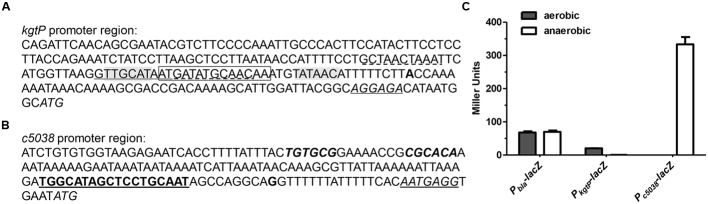
c5038 transcription was induced whereas kgtP repressed in anaerobiosis. (A) Promoter region of kgtP. (B) Promoter region of c5038. Italic, start codon; italic and underlined, putative ribosome binding site; bold, transcription start site; bold and underlined, RpoN binding site/σ54 motif (–12 and –24 regions); italic and bold, inverted repeats for KguR binding; shaded, –10 and –35 regions; Underlined (solid), perfect ArcA binding site; underlined (dashed), imperfect ArcA binding site; boxed, FNR binding site. (C)
kgtP and c5038 expression under aerobic and anaerobic conditions. Bacteria were grown aerobically or anaerobically in M9 medium containing KG as the sole carbon source. TMAO was used as an electron acceptor for anaerobic tests. Expression of c5038-lacZ or kgtP-lacZ was indicated by β-galactosidase activity. Pbla-lacZ constitutive expression was used as a control. Bars represent means ± SEM from three independent experiments performed in triplicate.